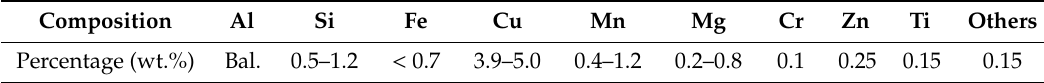
Table 2. Chemical composition of 2014-T6 aluminium